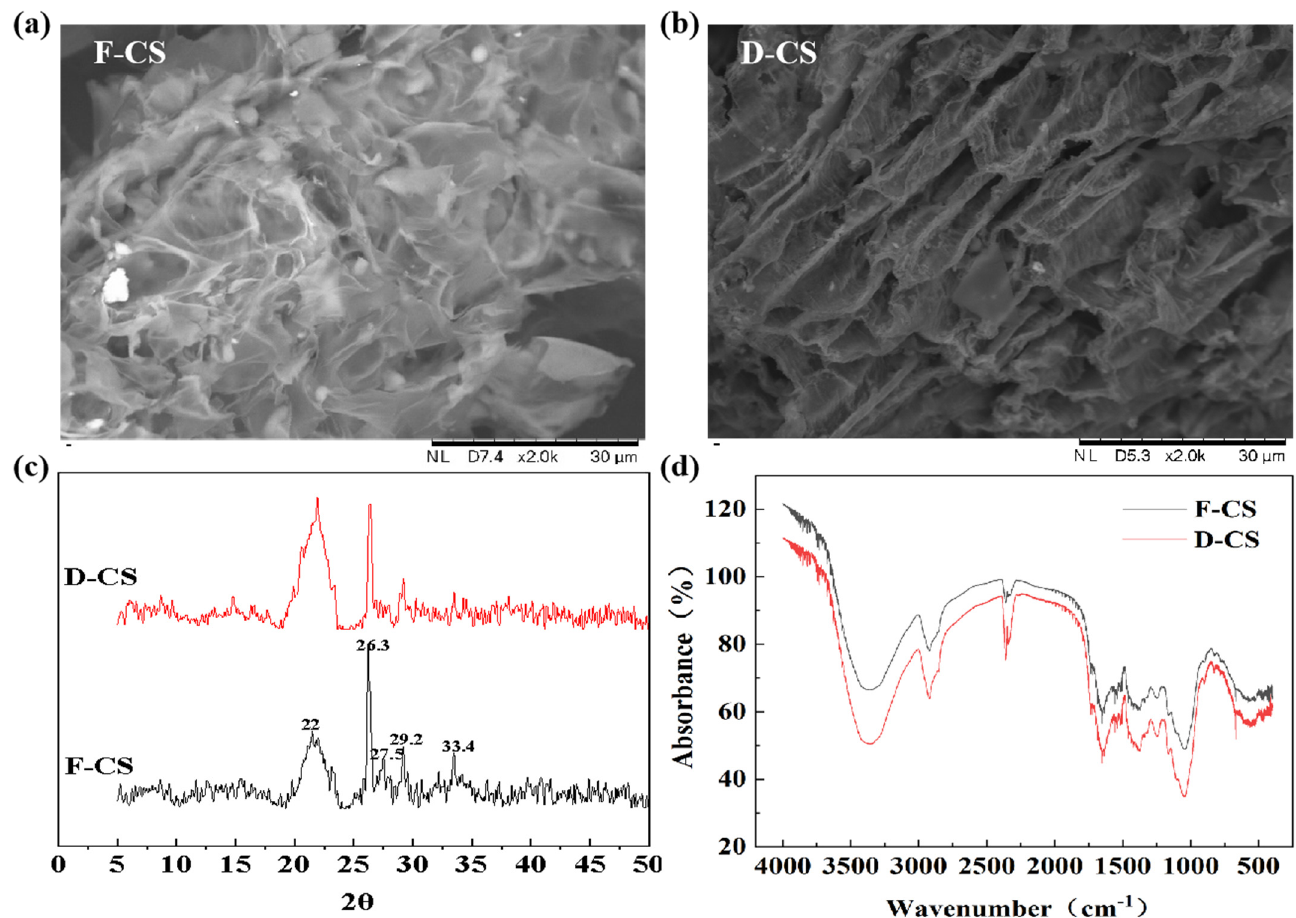
Figure 1. Nutritional structure of F-CS and D-CS, based on ( a ) SEM of F-CS (×2000 times), ( b ) SEM of D-CS (×2000 times), ( c ) FTIR of F-DS and D-CS, and ( d ) XRD of F-DS and D-CS.